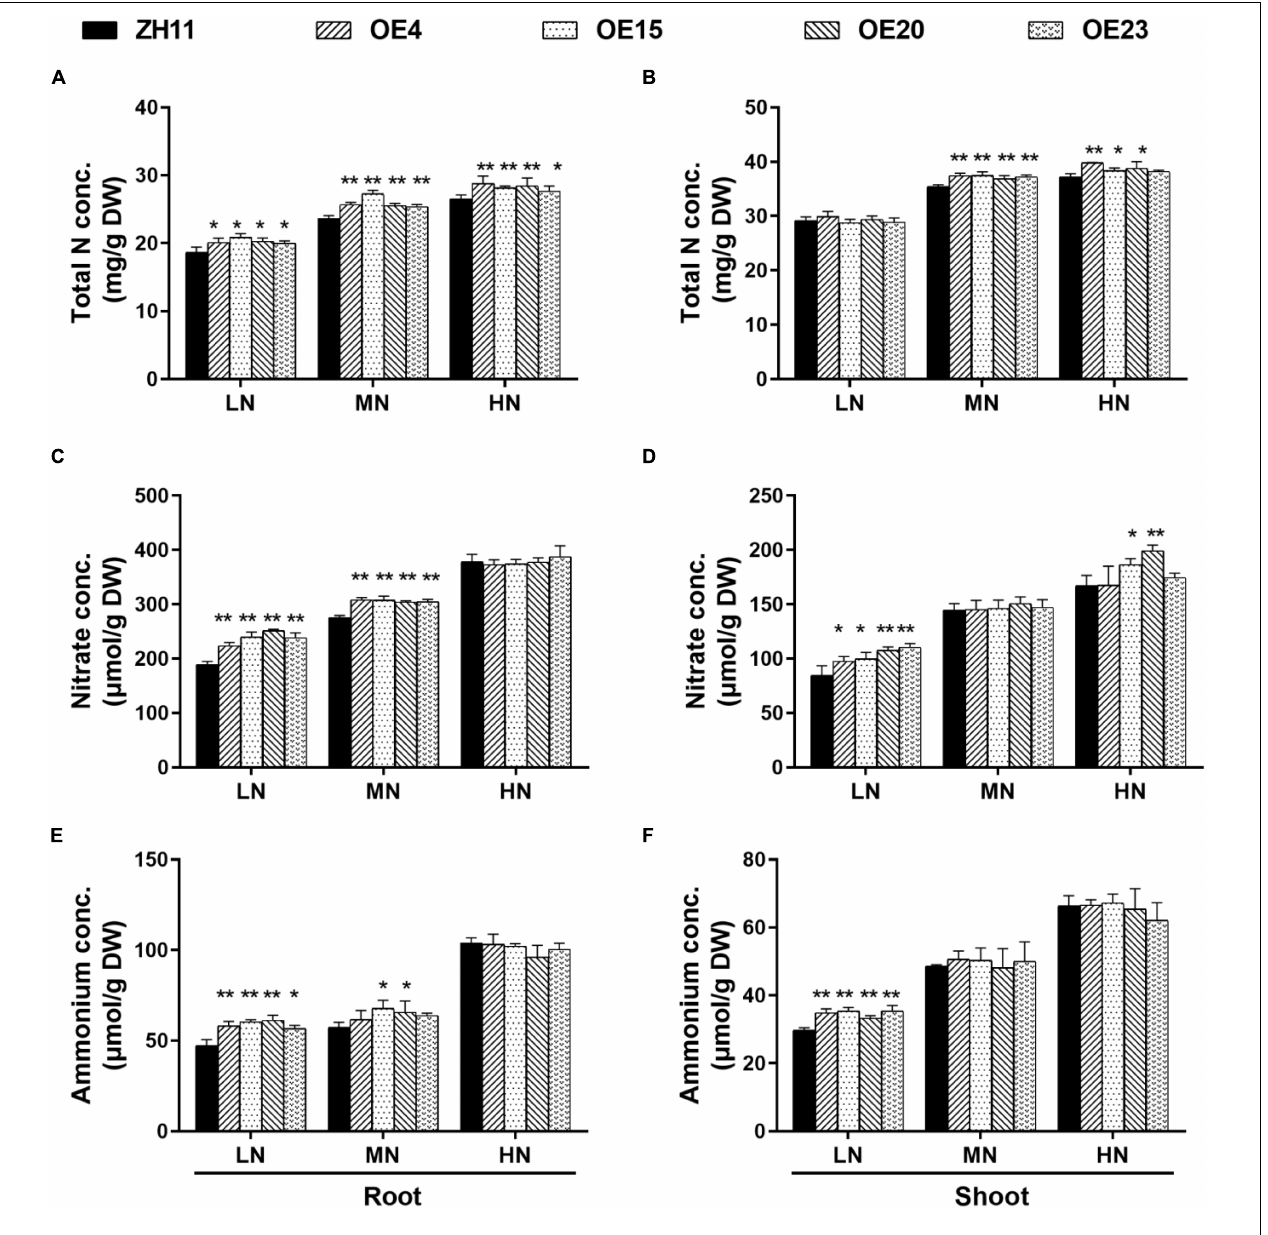
FIGURE 4 | The concentrations of total N, nitrate and ammonium in OsMYB305 -OE lines (OE4, OE15, OE20, OE23) and WT (ZH11). (A,B) Total N concentrations in the roots and shoots. (C,D) Nitrate concentrations in the roots and shoots. (E,F) Ammonium concentrations in the roots and shoots. Concs, concentrations; DW, dry weight. Values were means ± SD of 4 biological replications. The statistical significance was determined using the Student’s t -test (* P < 0.05, ** P < 0.01).